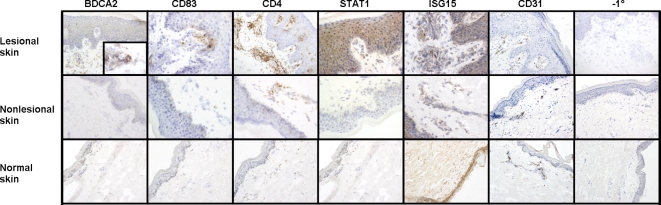
Immunohistochemical analyses of biopsies from psoriatic lesional and nonlesional skin and skin from normal donors.BDCA2 is a specific marker for pDCs, which are present at greater numbers in lesional skin (inset is 100×) compared with nonlesional skin, and not at all in skin from healthy donors. CD83 is a marker for mDCs; CD4 is present on T cells and dendritic cells. STAT1 protein staining was observed in the epidermis of lesional skin (both nuclear and cytoplasmic) and dermal mononuclear inflammatory cells, but not in nonlesional or skin from healthy donors. ISG15 protein increase was observed in psoriatic lesional skin and to a lesser extent in nonlesional skin but was not detected in the dermis of healthy donors. A positive tissue control (CD31) and an assay control (−1°) was included that eliminated the primary antibody from the immunohistochemical assay.